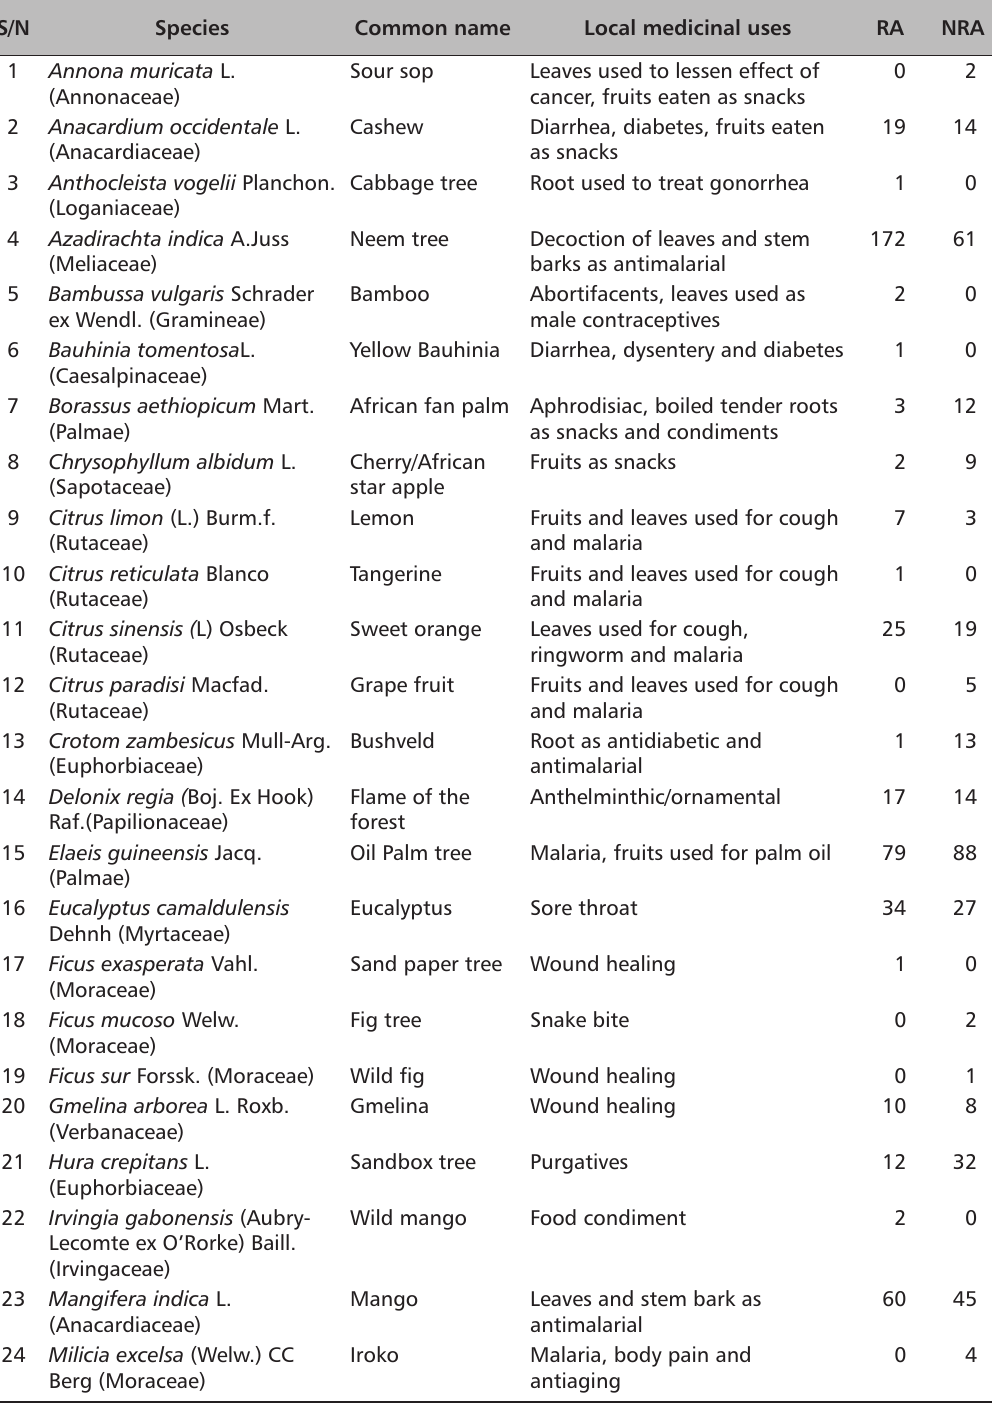
TABLE 1. Species composition and richness of ethno-medicinal